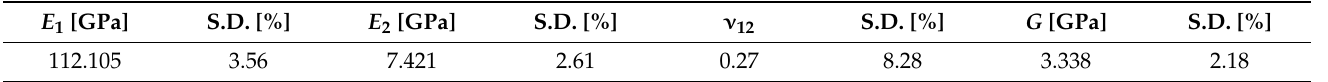
Table 1. Material properties of carbon/epoxy composite laminates.